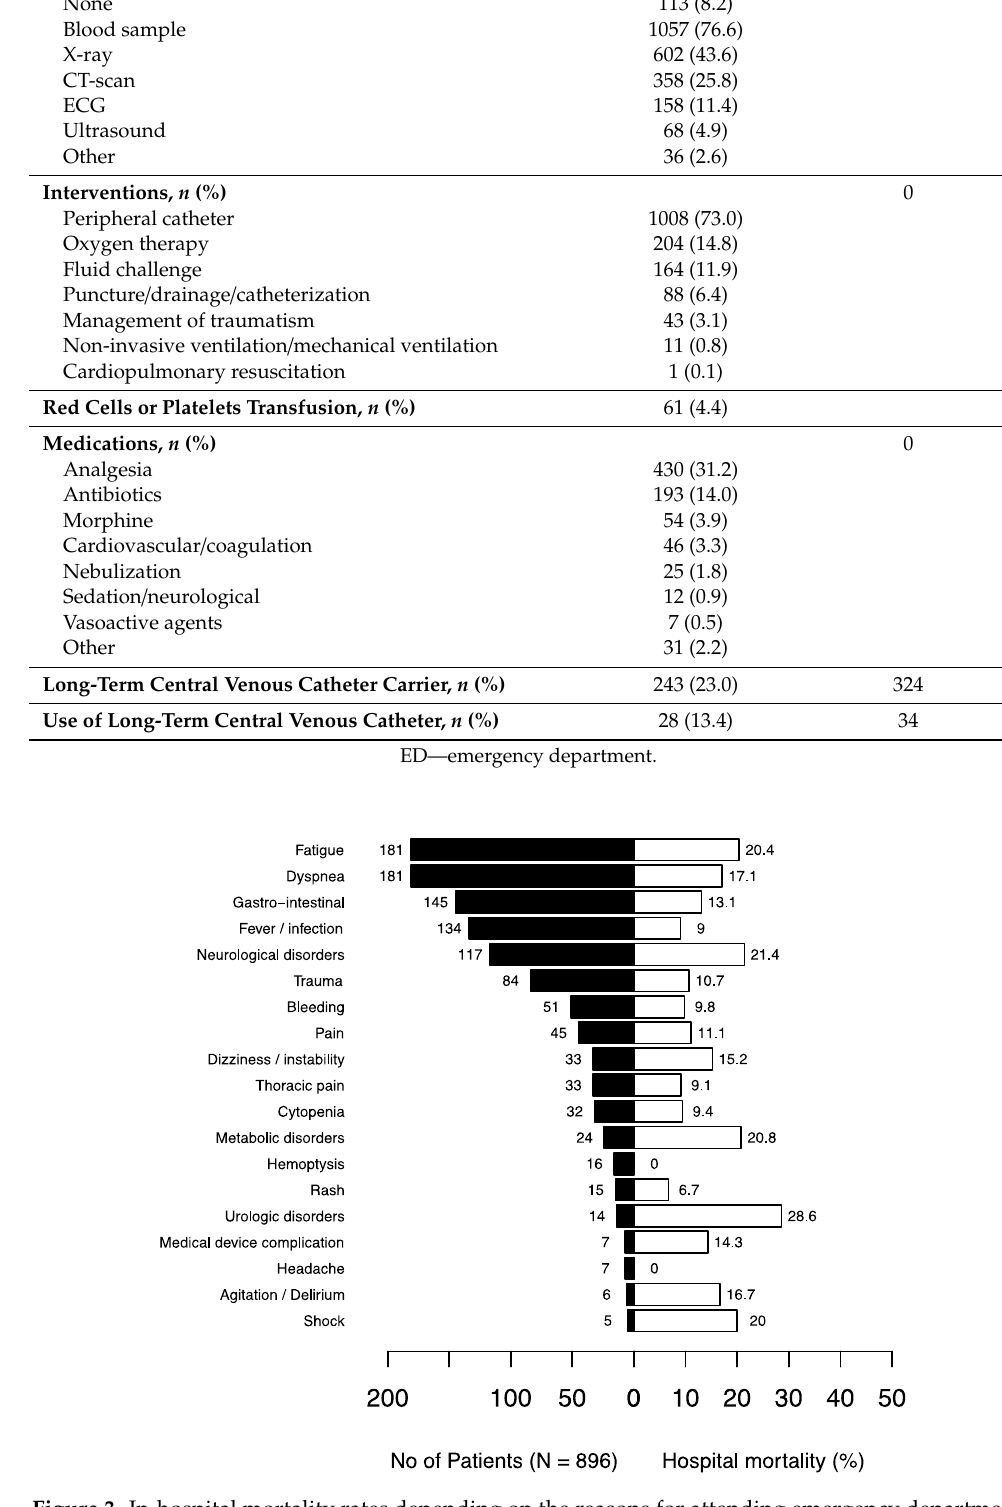
Figure 3. In-hospital mortality rates depending on the reasons for attending emergency departments in hospitalized cancer patients.